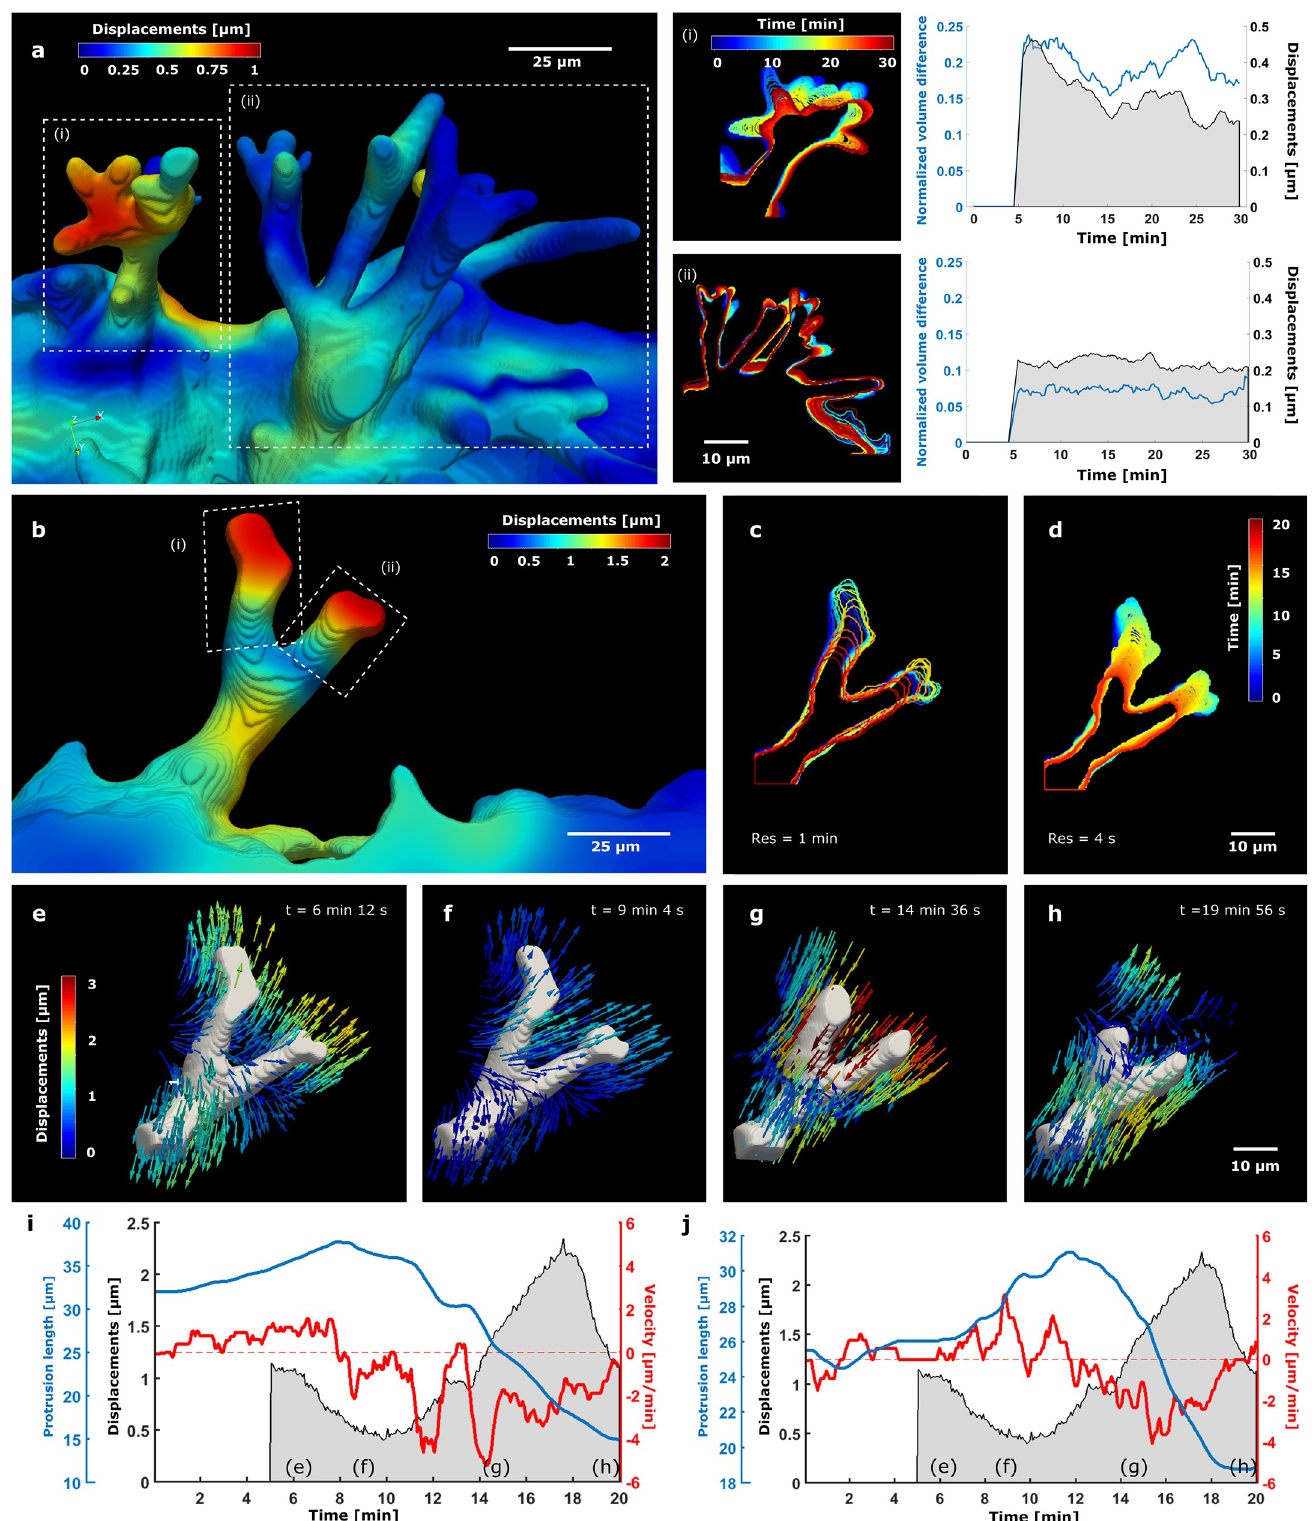
Fig 3. Fast 4D displacement microscopy around dynamic sprout protrusions. (a) 3D rendering of sprouts imaged with fast local SPIM scanning (every 10 seconds), with the magnitude of local incremental matrix displacements (t ref = ti − 5 min) mapped on the surface. Contour evolution plot and activity profile of an